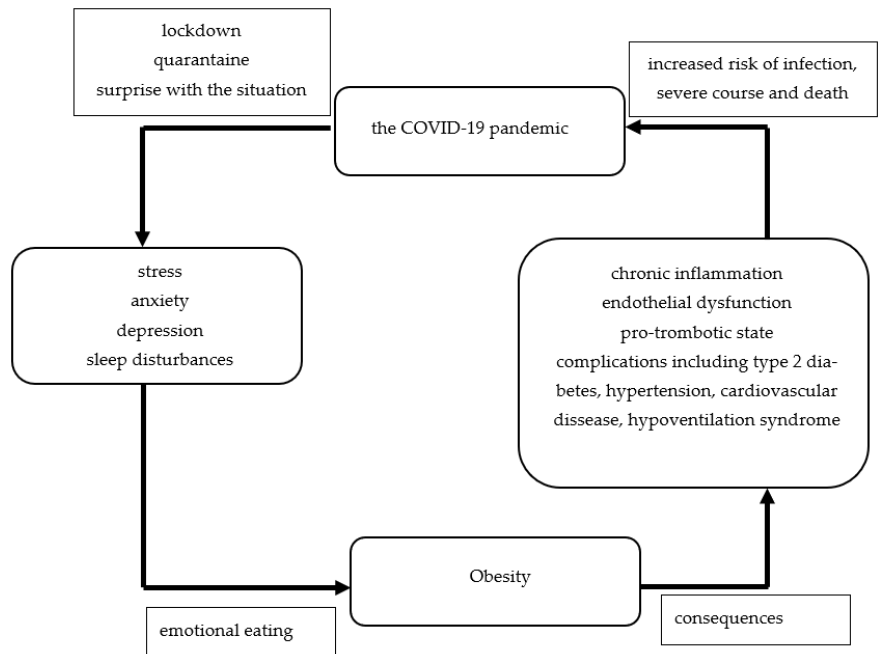
Figure 6. The bidirectional association between obesity and the COVID-19 pandemic.